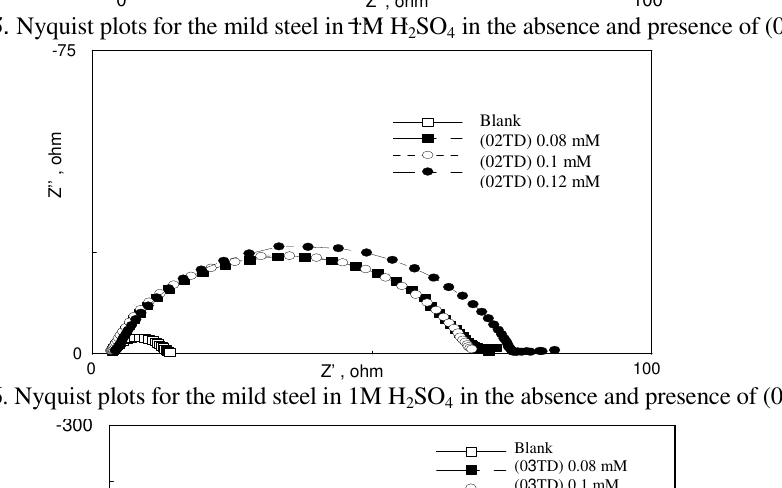
Figure 5 . Nyquist plots for the mild steel in 1M H